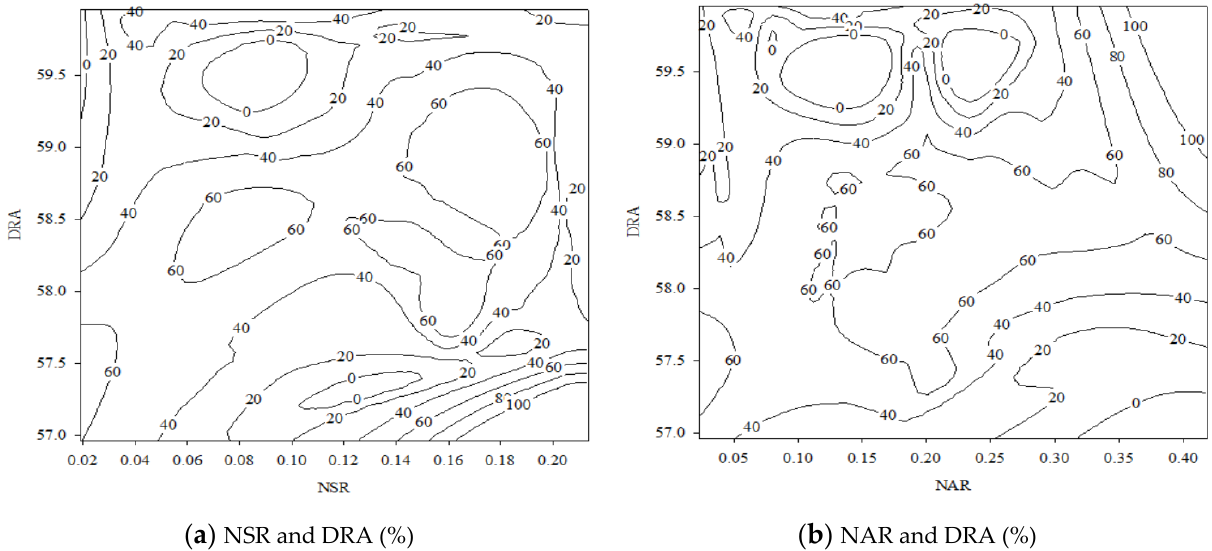
Figure 3. Relationship between compressive strength and the first three significant fac- tors of the SCSGPs , i.e., ( a ) the NSR and the DRA (%); ( b ) the NAR and the DRA